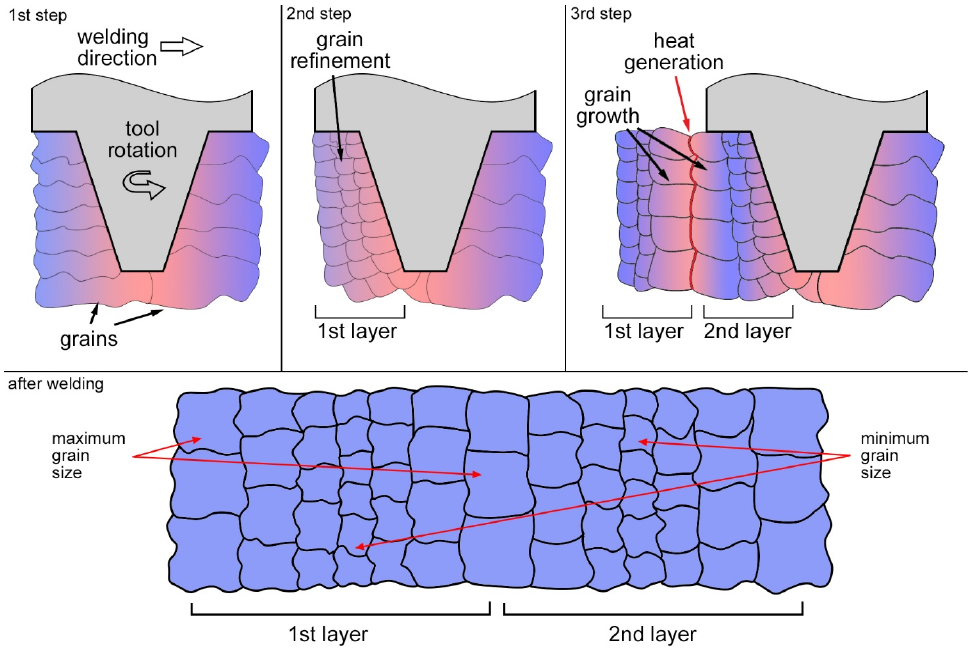
Figure 13. Figure 13. Transfer layer recrystallization scheme and a model of gradient structure in a longitudi ‐ nal section.